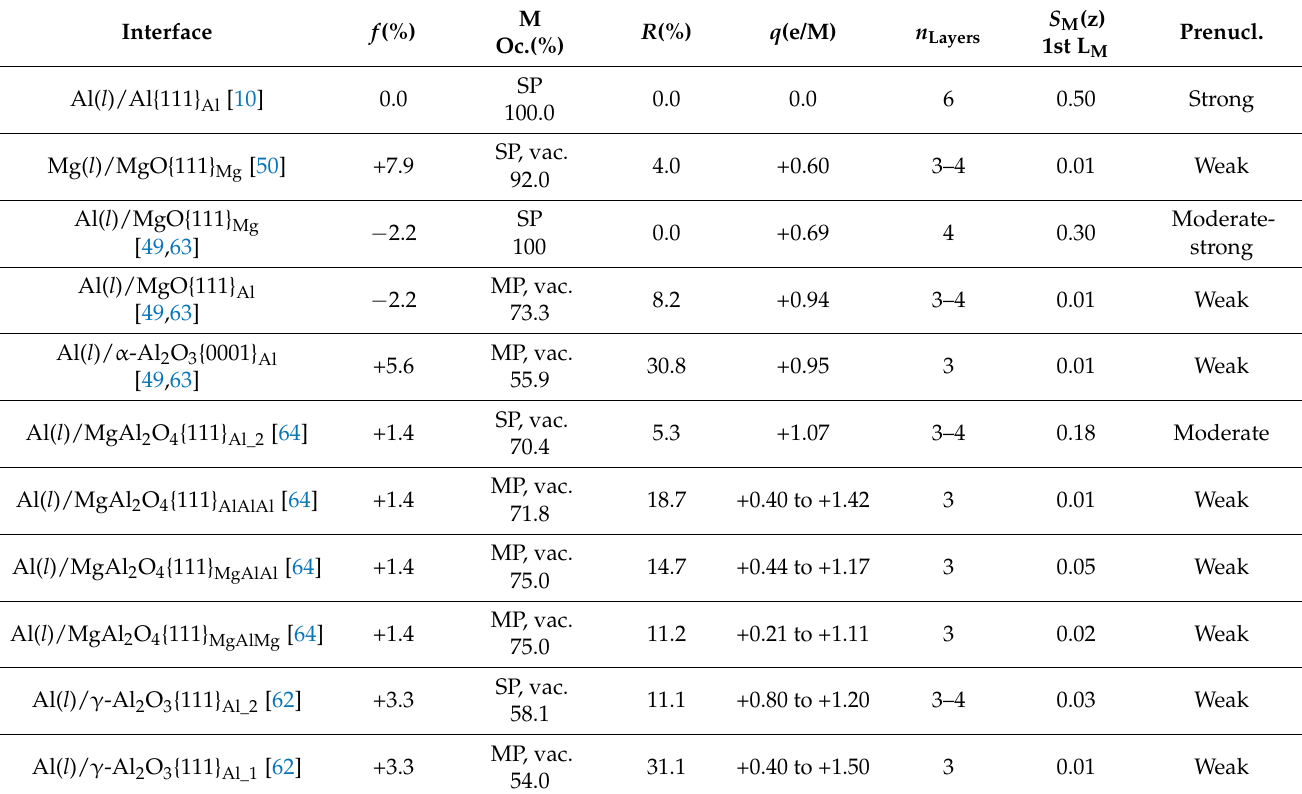
Table 5. Summary of the characteristics of the terminating metal layer in different M( l )/oxide